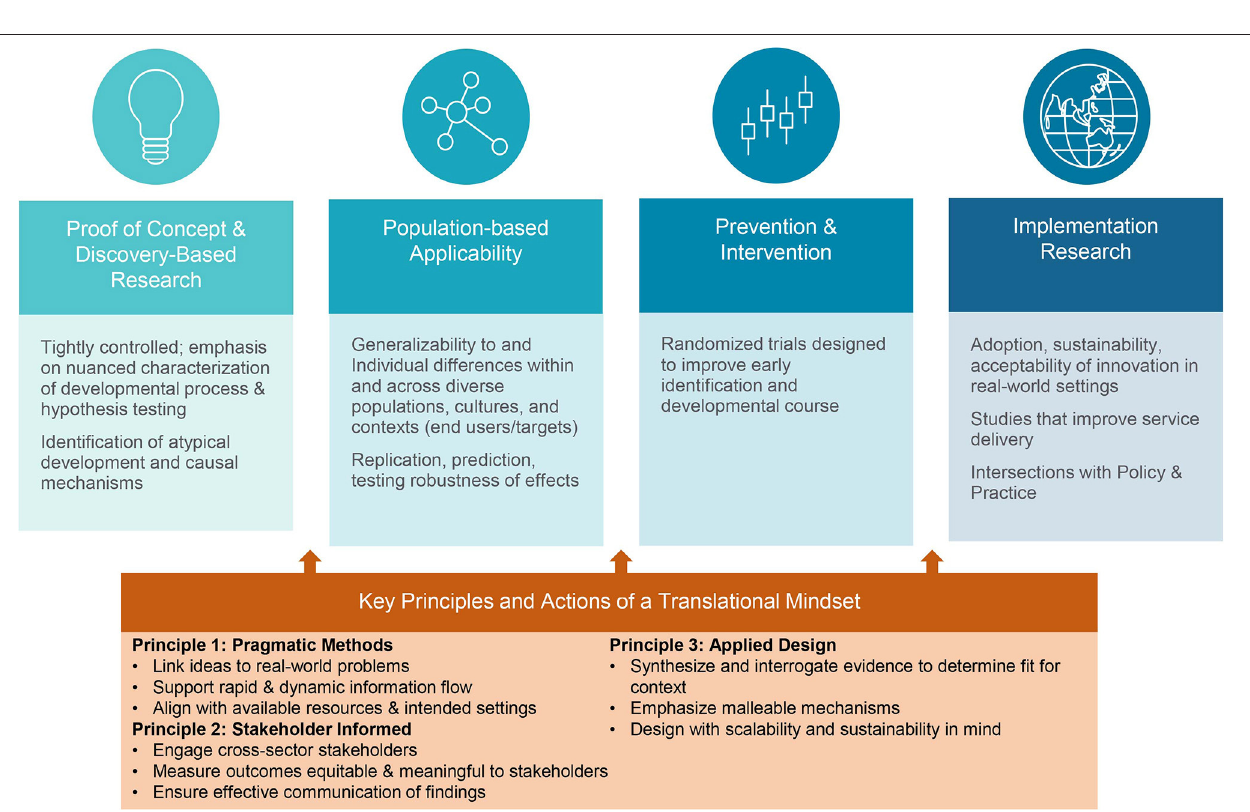
FIGURE 2 | Translational mindset heuristic across the developmental sciences research spectrum.